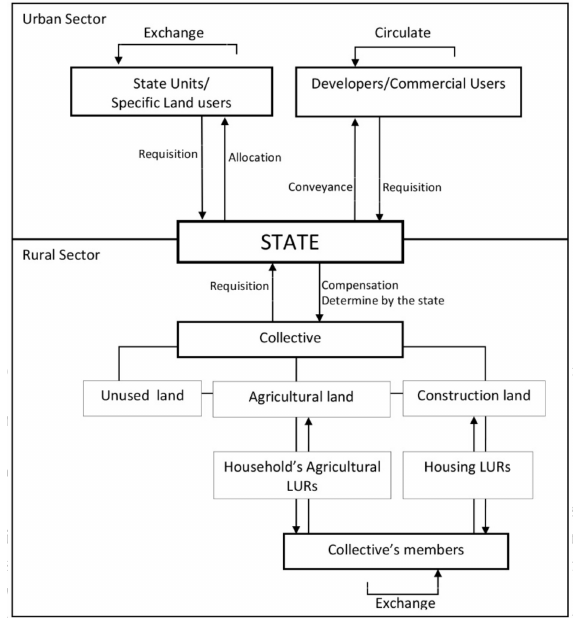
Figure 2. Framework of rural–urban land system in China (Source: the